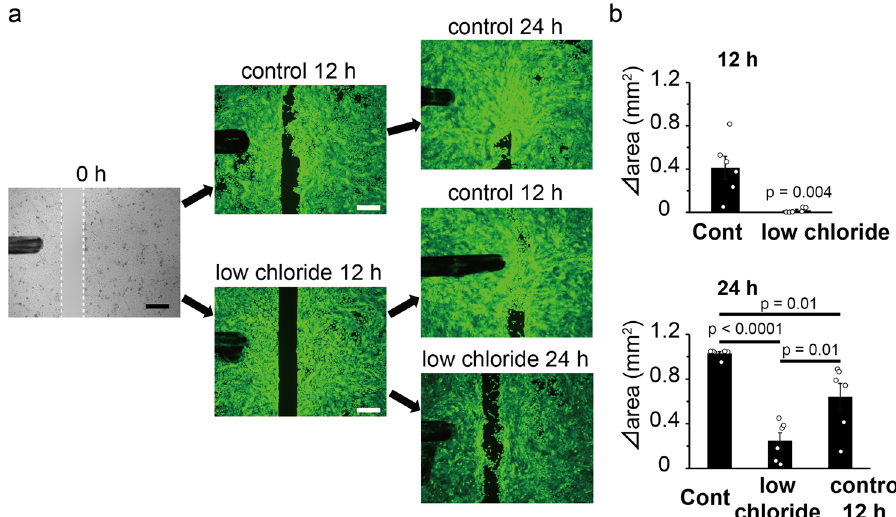
Fig. 6 Effects of a low chloride medium on cell migration/proliferation in the culture insert assay. a Culture insert assay in a low chloride medium or control medium. Bright fi elds at 0 h and calcein staining at 24 h. White dotted lines at 0 h indicate the borders of the cells. Control 12 h indicates a change of medium from low chloride medium to control medium at 12 h. Scale bars indicate 500 μ m. b Measurements of increased areas ( Δ area) at 12 or 24 h in the low chloride medium or control medium. Data represent means ± S.E.M ( N = 6). Statistical signi fi cance was determined with the Mann – Whitney test or one-way ANOVA followed by Tukey correction.